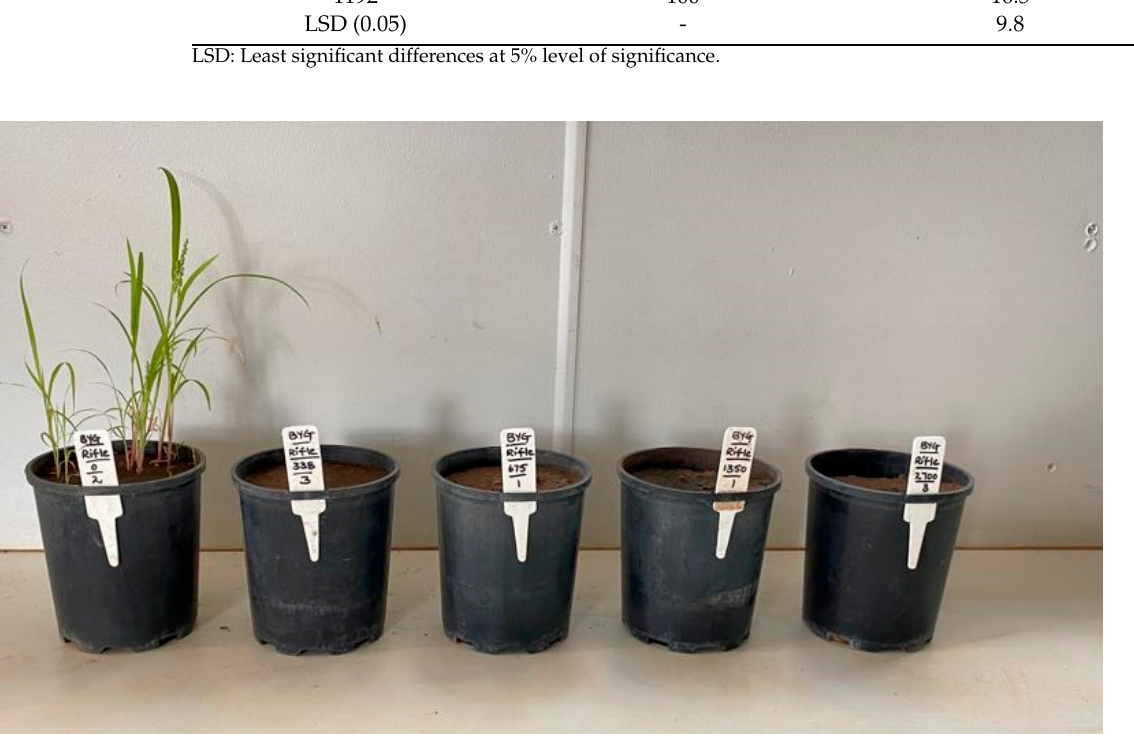
Figure 3. Echinochloa colona seedlings in response to pendimethalin doses (Left to Right: Pendimethalin doses are in increasing order: 0, 149, 298, 596, and 1192 g ai ha − 1 .